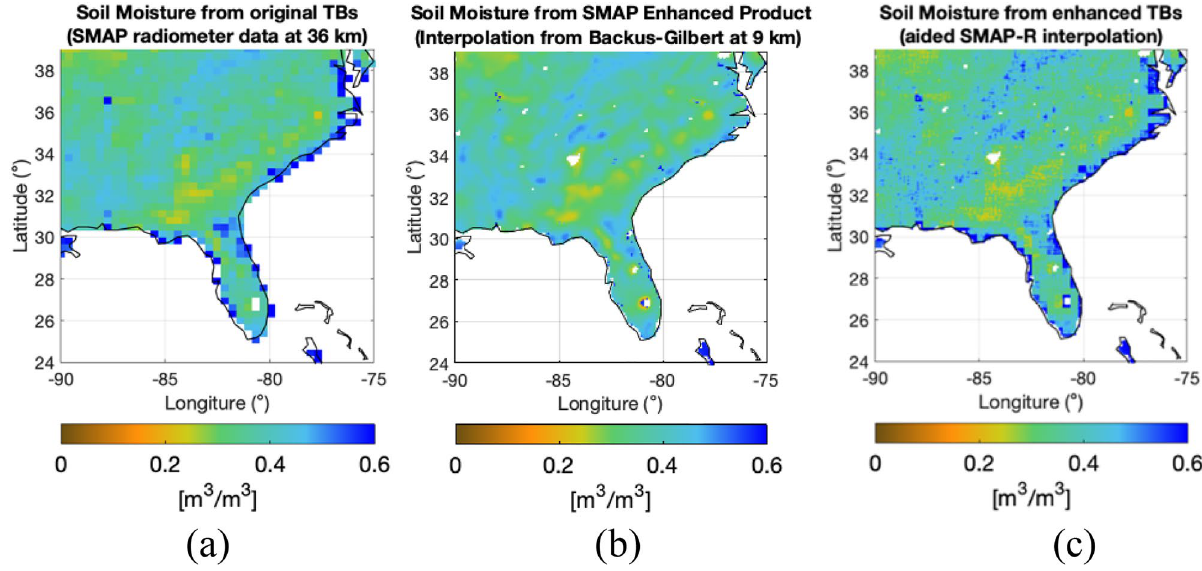
Figure 6. SM retrieved over Florida’s region using ( a ) original T Bv from SMAP radiometer alone at 36 km, ( b ) enhanced T Bv through Backus-Gilbert, and ( c ) aided-interpolated T Bv resulting from combining SMAP